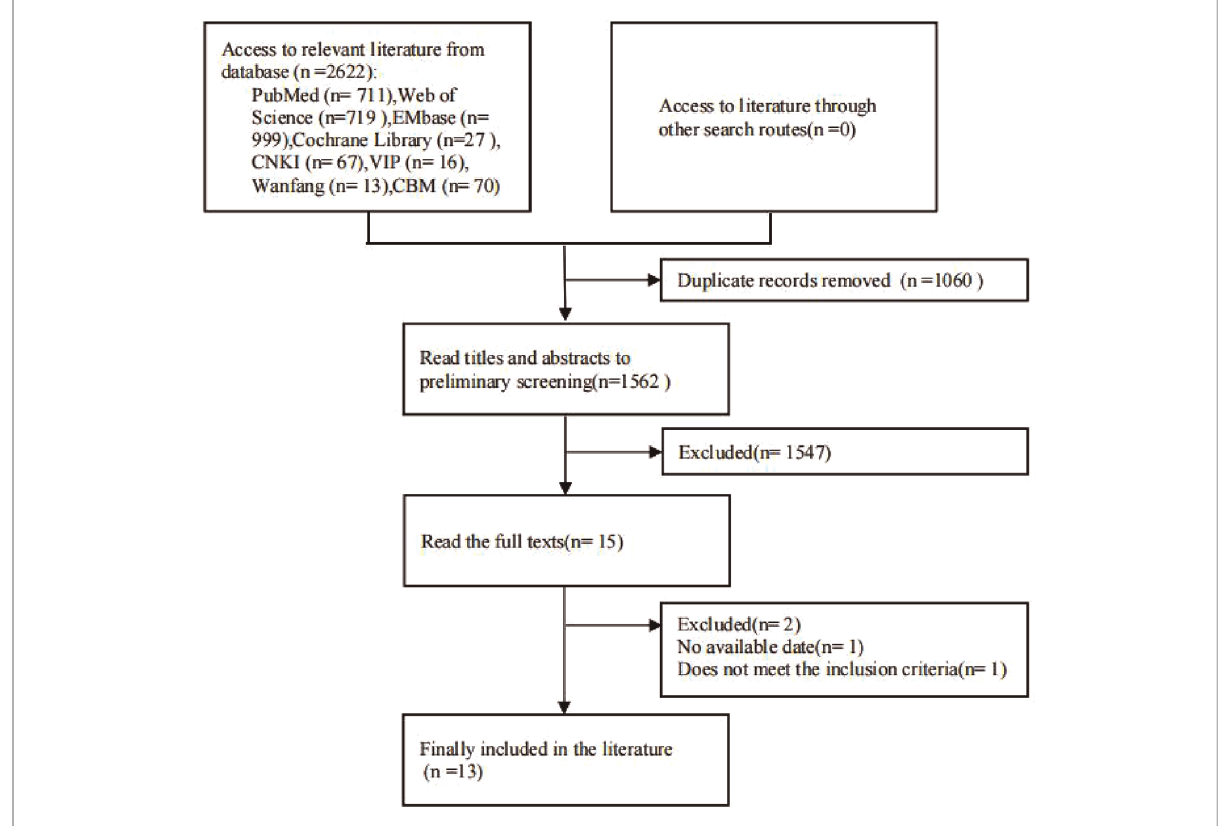
FIGURE 1 Flow diagram of